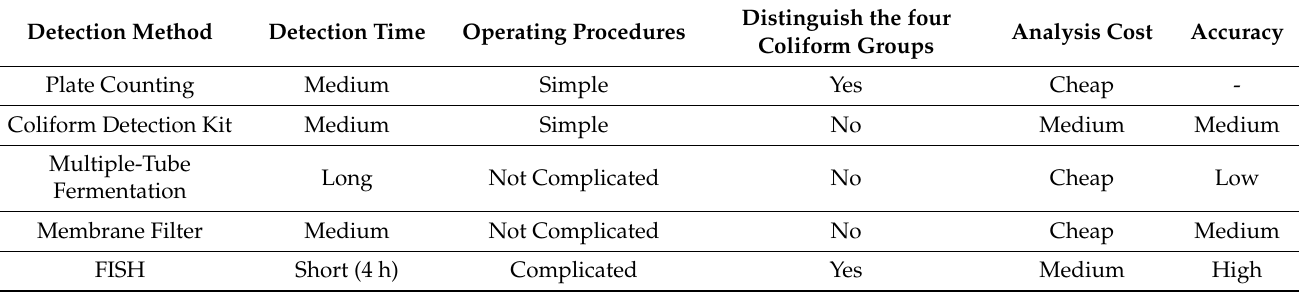
Table 2. Comparison between the FISH method and conventional water detection methods. Detection